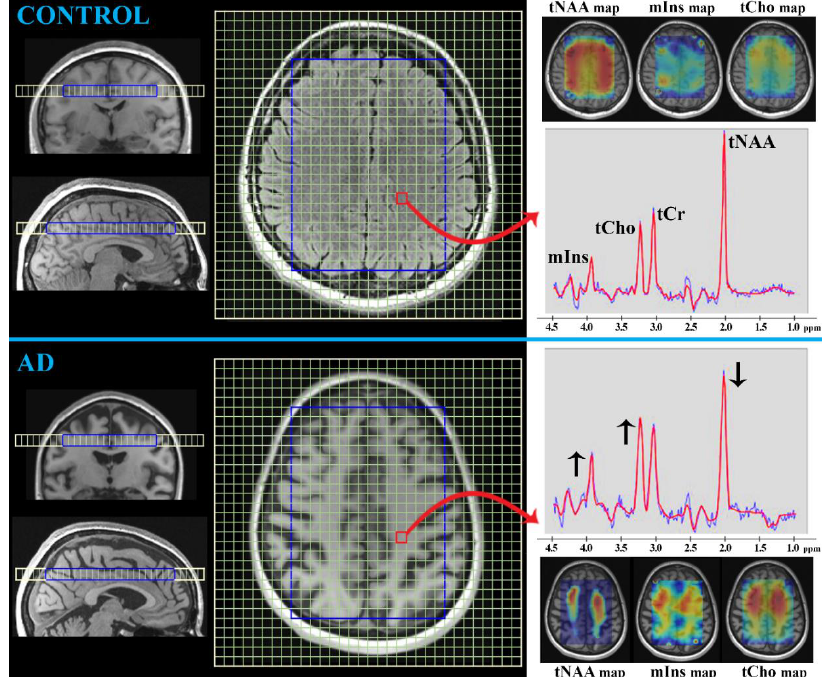
Figure 4. Example of 1 H MRS neuroimaging (T 1 -weighted MRI at 3 Tesla MR-scanner) obtained by the multivoxel spectroscopy approach with the presented spectra (one selected voxel indicated with the red square and arrow) showing the main metabolite peaks: total creatine (tCr), total choline (tCho), total N-acetyl-aspartate (tNAA), and myo-Inositol (mIns). The 1 H MRS spectra for a control subject (50-year-old female) and AD patient (55-year-old female) are depicted with the typical metabolic peak changes being indicated by black arrows ( ↓ : decreased, ↑ : increased). Metabolic maps of the brain tissue are also shown (tNAA, mIns, and tCho maps).